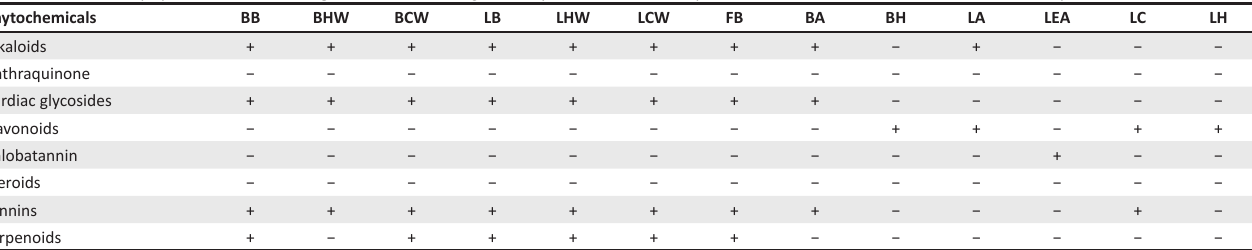
TABLE 1: Qualitative phytochemical screening of the different C. grandicalyx extract, results reported as standard deviation ± mean of three replicates. Phytochemicals Anthraquinone